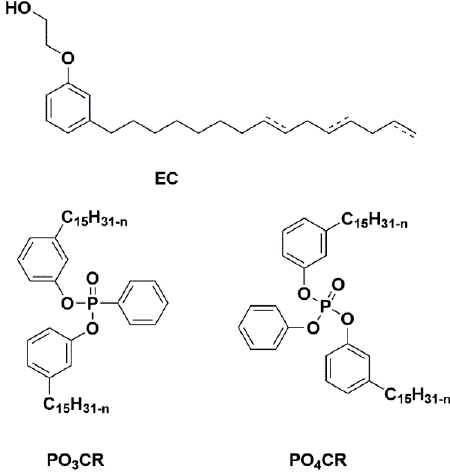
Figure 2. Structures of EC, PO 3 CR and PO 4 CR molecules.